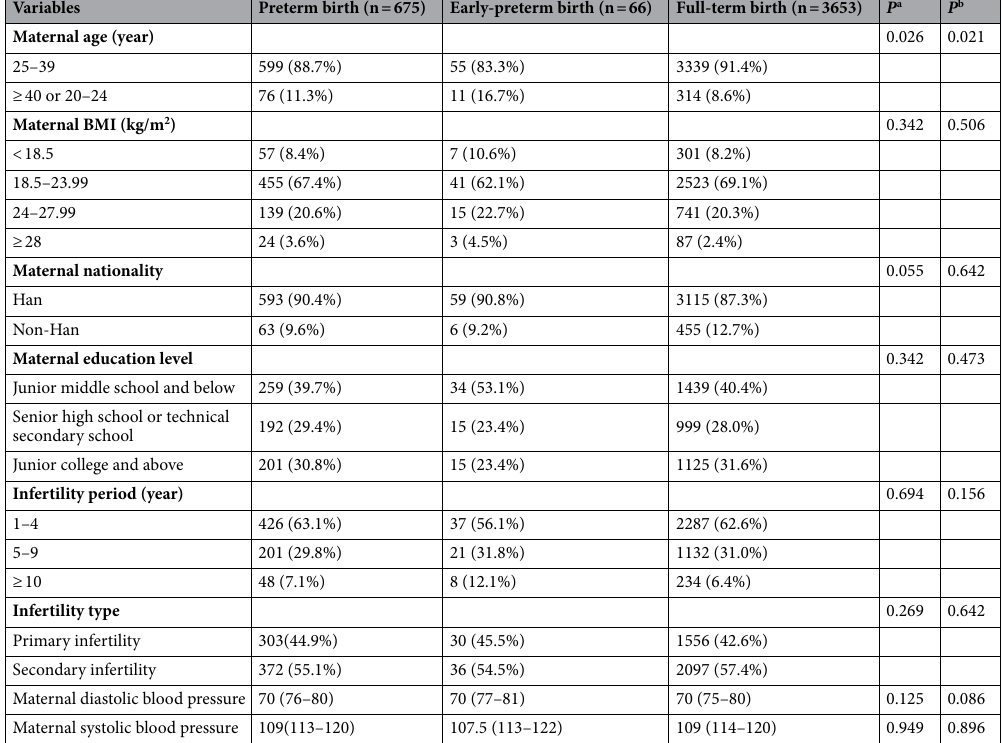
Table 1. Basic parameters before super-ovulation were compared between preterm birth group and full-term birth group. BMI body mass index. a Preterm birth group vs.full-term birth. b Early-preterm birth group vs.full- term